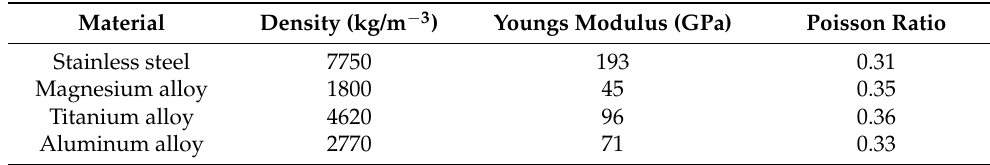
Table 1. Most commonly available alloys and their